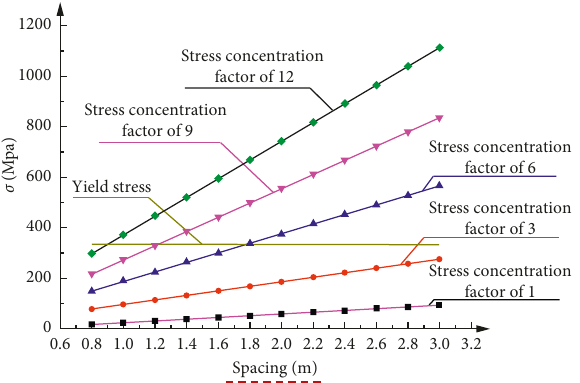
Figure 24: Vertical stress variation under different stress con- centration factors at different spacings. The black curve represents the equivalent stress of U-shaped steel under the concentration stress coefficient of 1, the red curve represents the case where the concentration stress coefficient is 3, the blue curve represents the case where the concentration stress coefficient is 6, the pink curve represents the concentration stress coefficient of 9, the green curve represents the concentration stress coefficient of 12, and the brown represents the yield stress of U-shaped